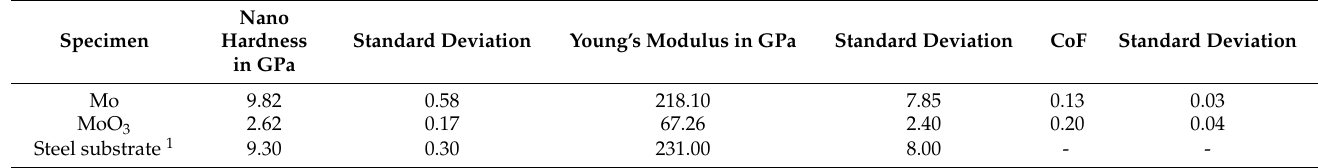
Table 3. Average values of the nano hardness, the Young’s modulus, and the CoF for the Mo and MoO 3 coating and the steel